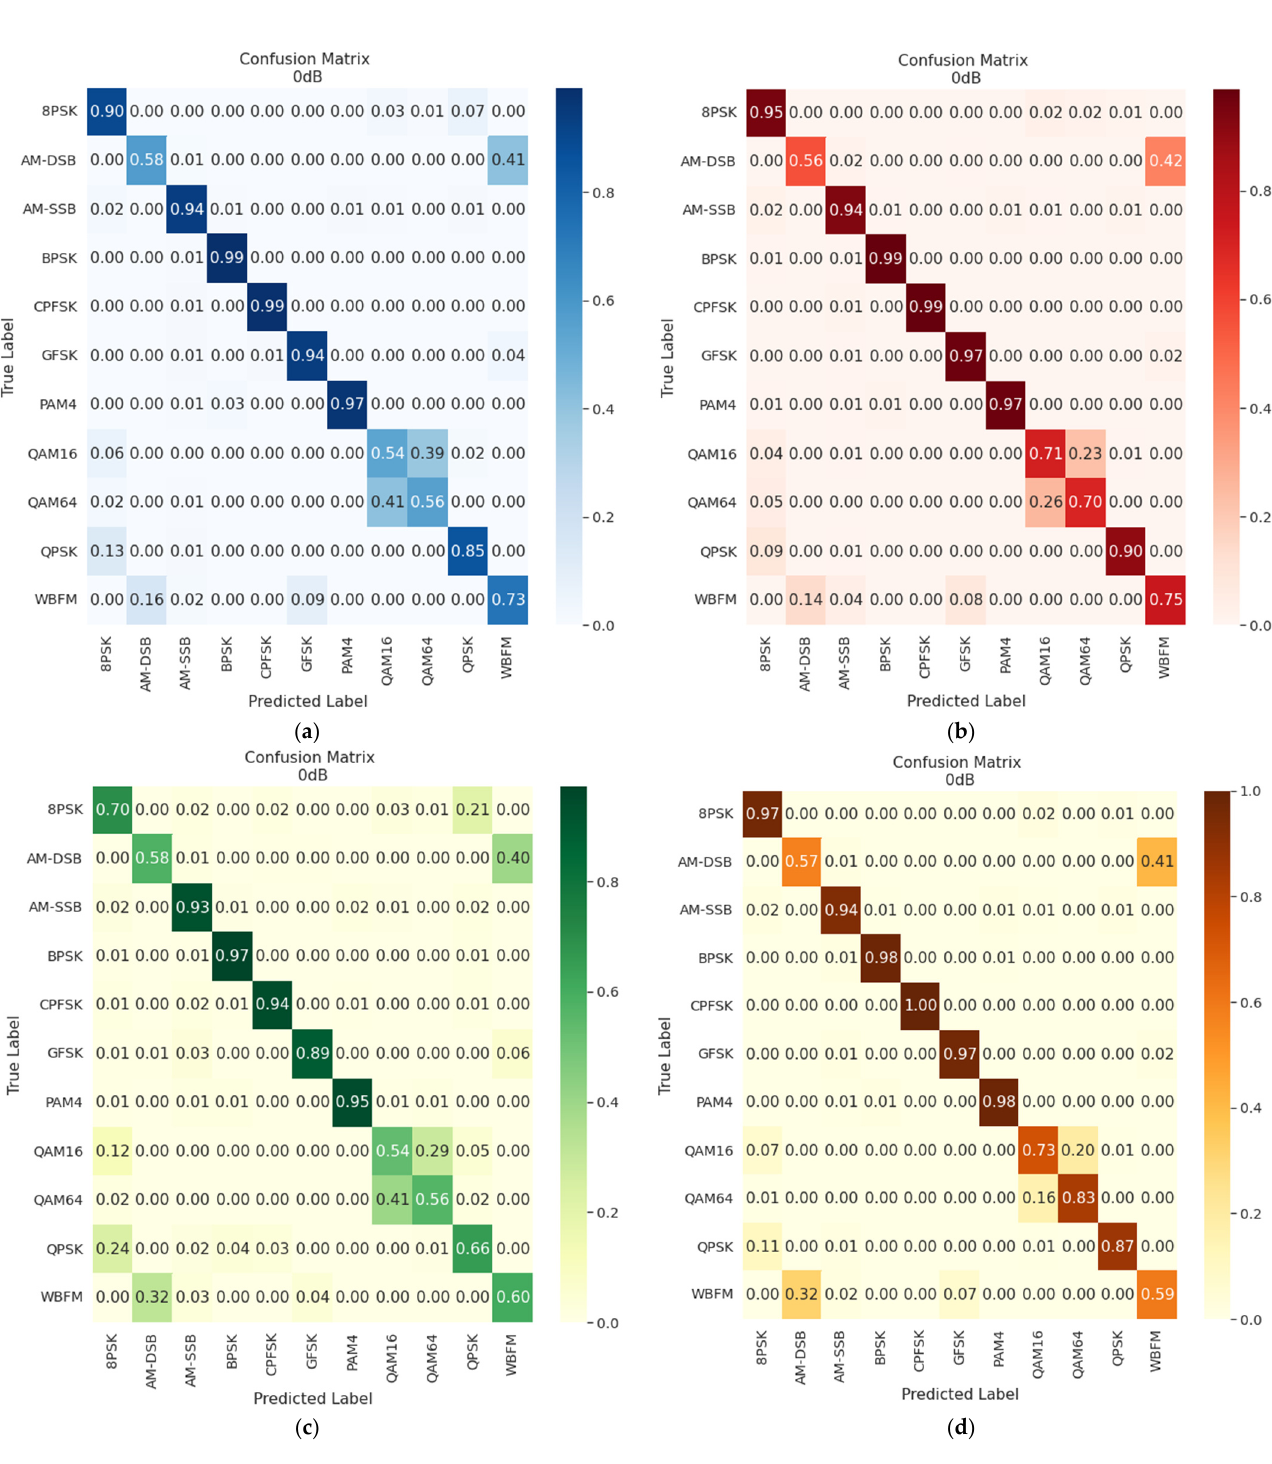
Figure 20. Confusion matrices at SNR 0 dB for ( a ) CNN 1D; ( b ) CNN + LSTM; ( c ) CNN 2D; ( d ) biLSTM.